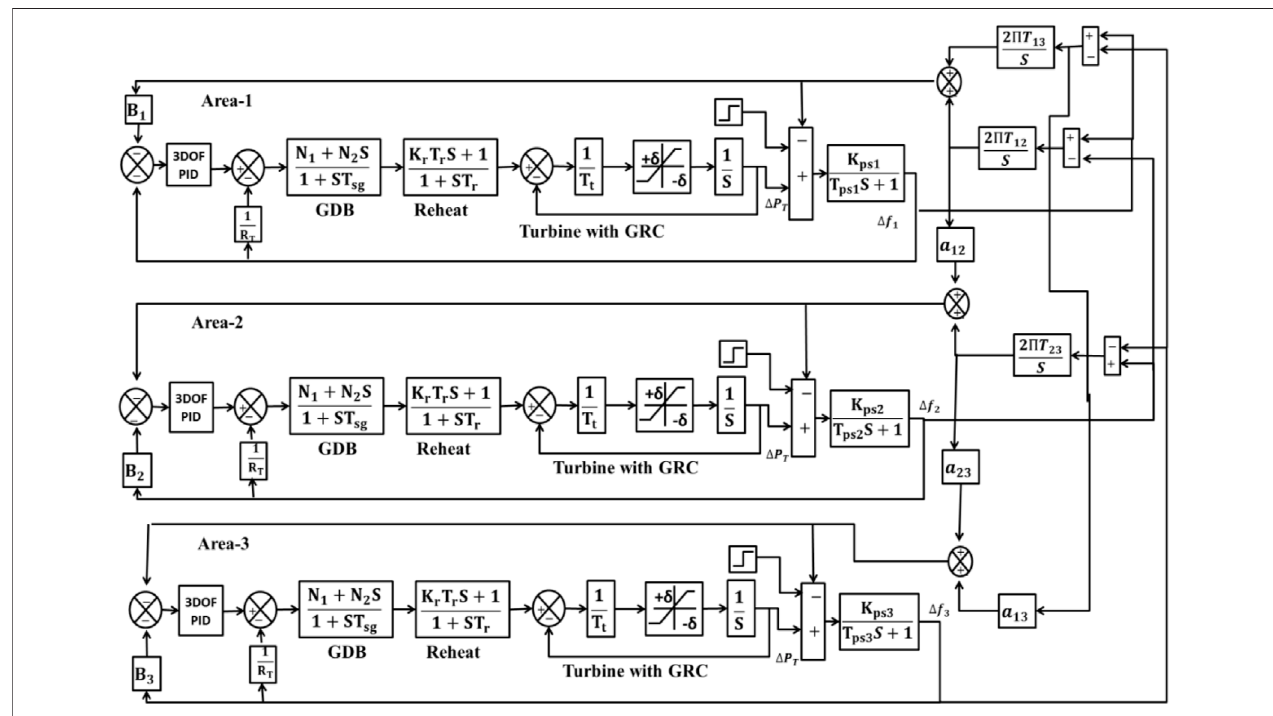
FIGURE 2 | Model of the three-area RTPS system (Morsali et al., 2014).